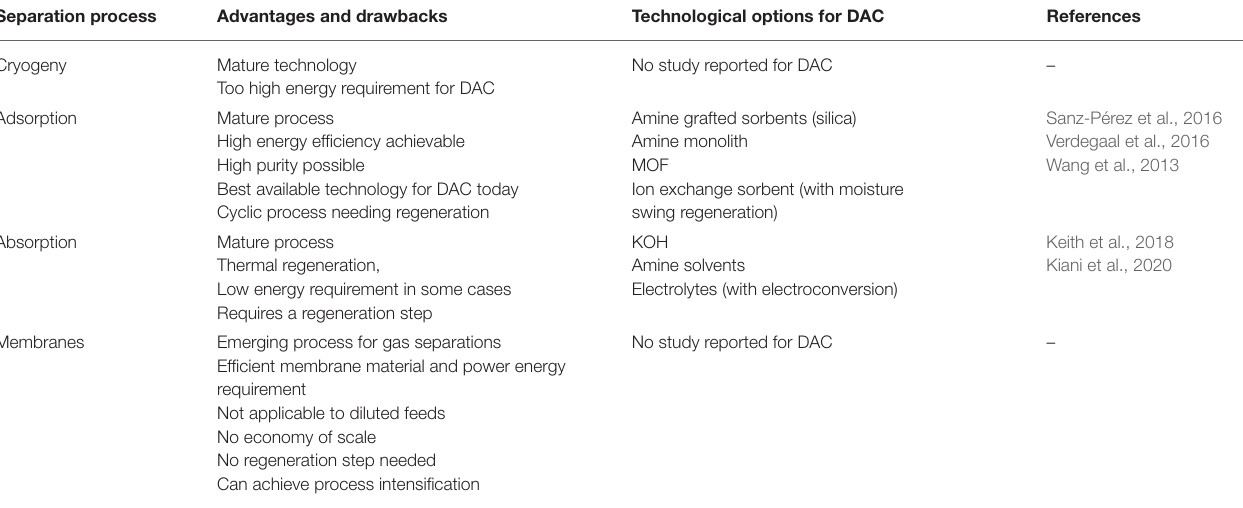
TABLE 1 | Overview of the different gas separation processes and current state-of-the-art technologies for DAC